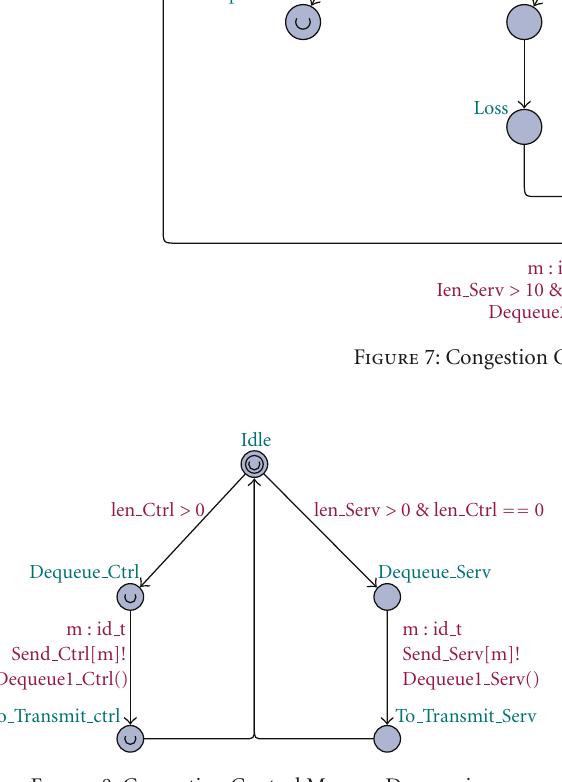
Figure 8: Congestion Control Message Dequeueing.